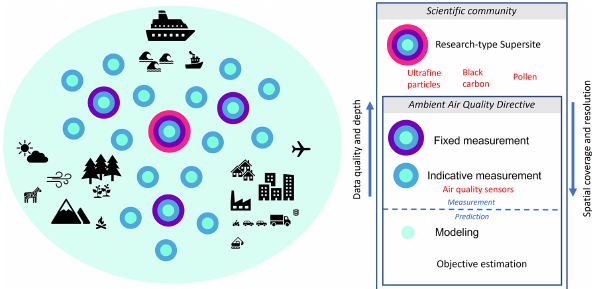
Figure 1. Concept map of air quality monitoring, which combines both regulatory measurements and research-type supersite